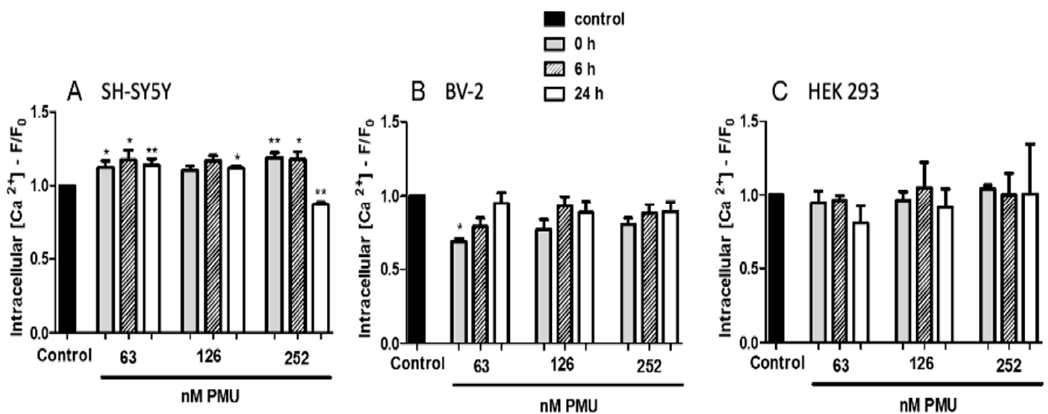
Figure 5. Levels of intracellular Ca 2+ of cells cultured in the presence of PMU. Cultured ( A ) neuroblastoma, SH-SY5Y, ( B ) microglia, BV-2, and ( C ) kidney, HEK293, were incubated with the fluorophore calcium probe Fluo4 (0.33 mg/100 µ L for 45 min), washed to remove the excess of the probe and then treated with PMU (63, 126, 252 nM) for 0, 6 or 24 h. Cells treated with NaPB 7.0 were taken as controls. The fluorescence (excitation 488 nm/emission 530 nm) intensity was then measured, and the values found for controls were considered as 1.0. The results are the mean ± SEM ( n = 4 for the control and 4–5 for treatments). The data were analyzed by one-way parametric ANOVA with a Dunnett post-test. * p < 0.05 and ** p < 0.01 vs. control.